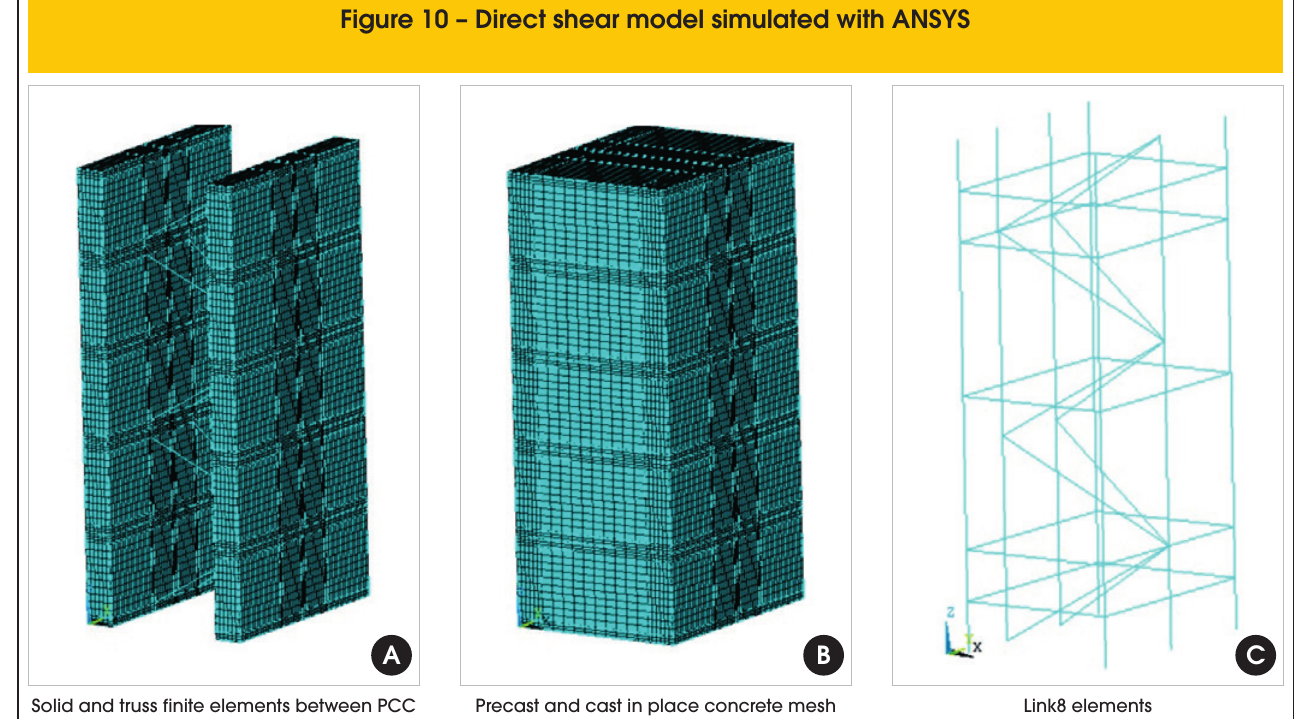
Figure 10 – Direct shear model simulated with ANSYS